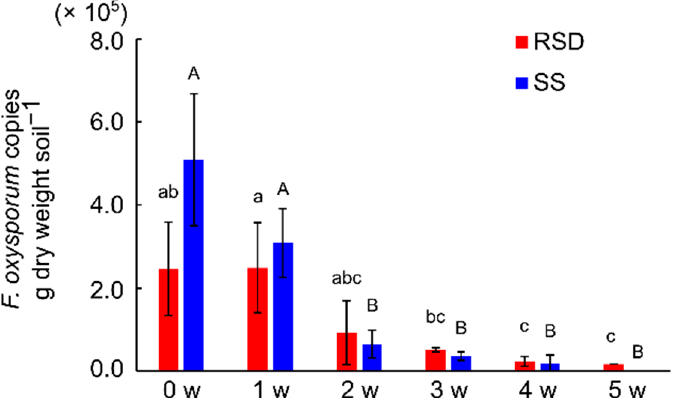
Figure 6. Populations of Fusarium oxysporum in the soil samples under reductive soil disinfestation (RSD) and soil solarization (SS). Red denotes RSD, whereas blue denotes SS. Values are the average, and error bars indicate standard deviation ( n = 3). Different letters (a–c for RSD; A and B for SS) represent significant differences ( p < 0.05) according to Tukey’s test. 0–5 w, treatment period for 0 to 5 weeks.